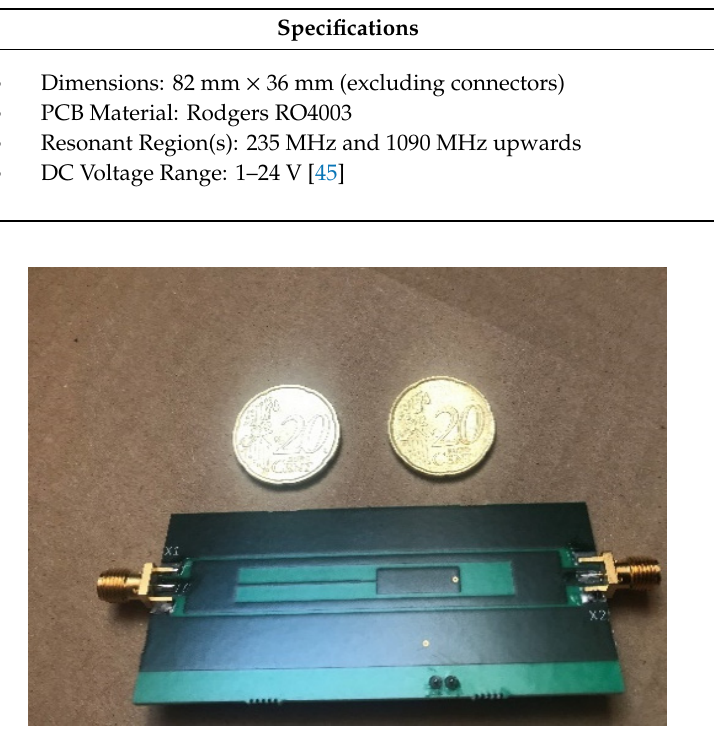
Figure 2. Developed Tag.